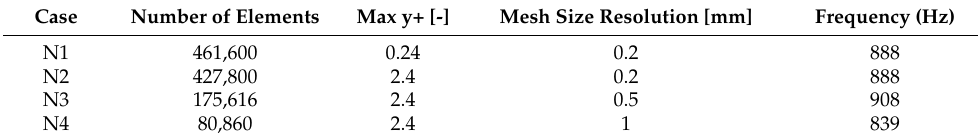
Table 1. Details of the checked meshes and results obtained for the mesh independency study.